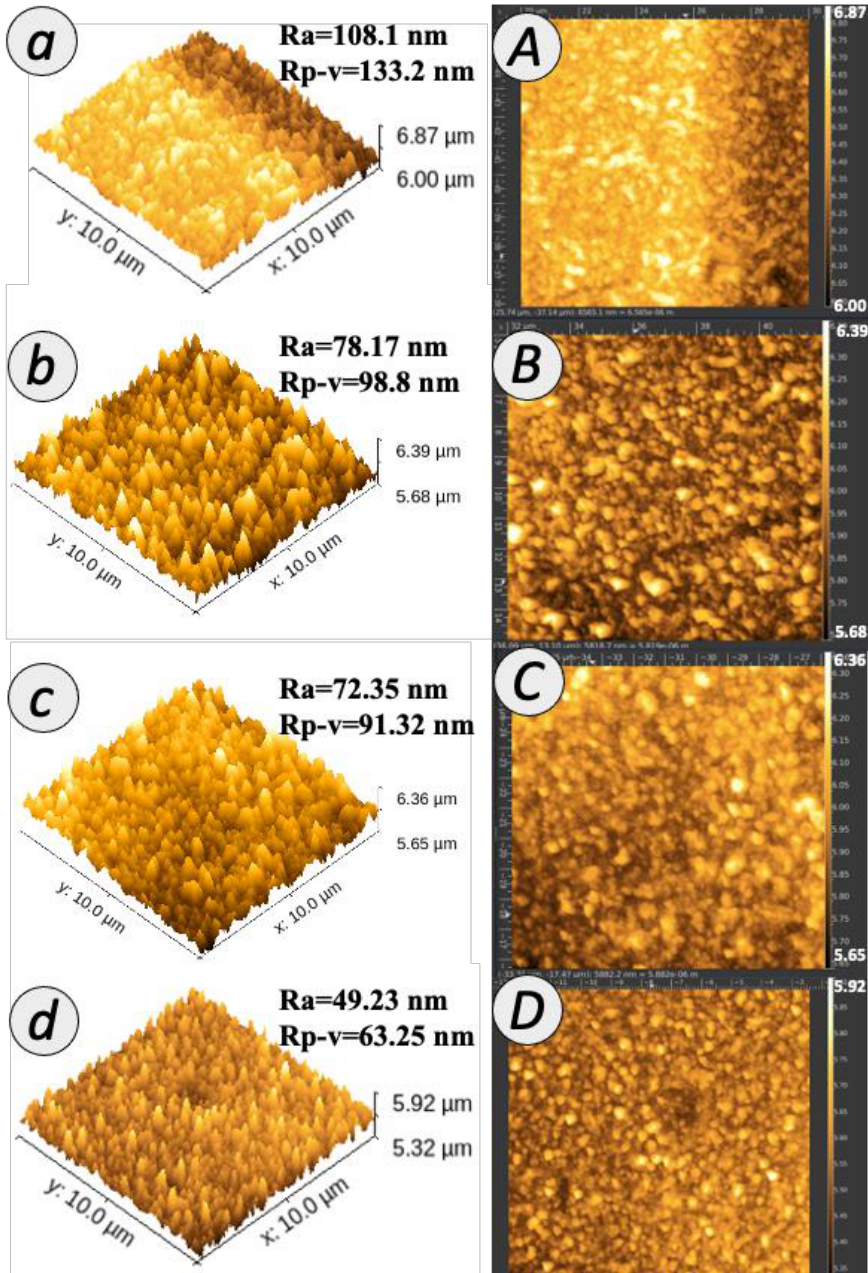
Figure 6. AFM of membrane surface with ( a – e ) three- and ( A – E ) two-dimensional